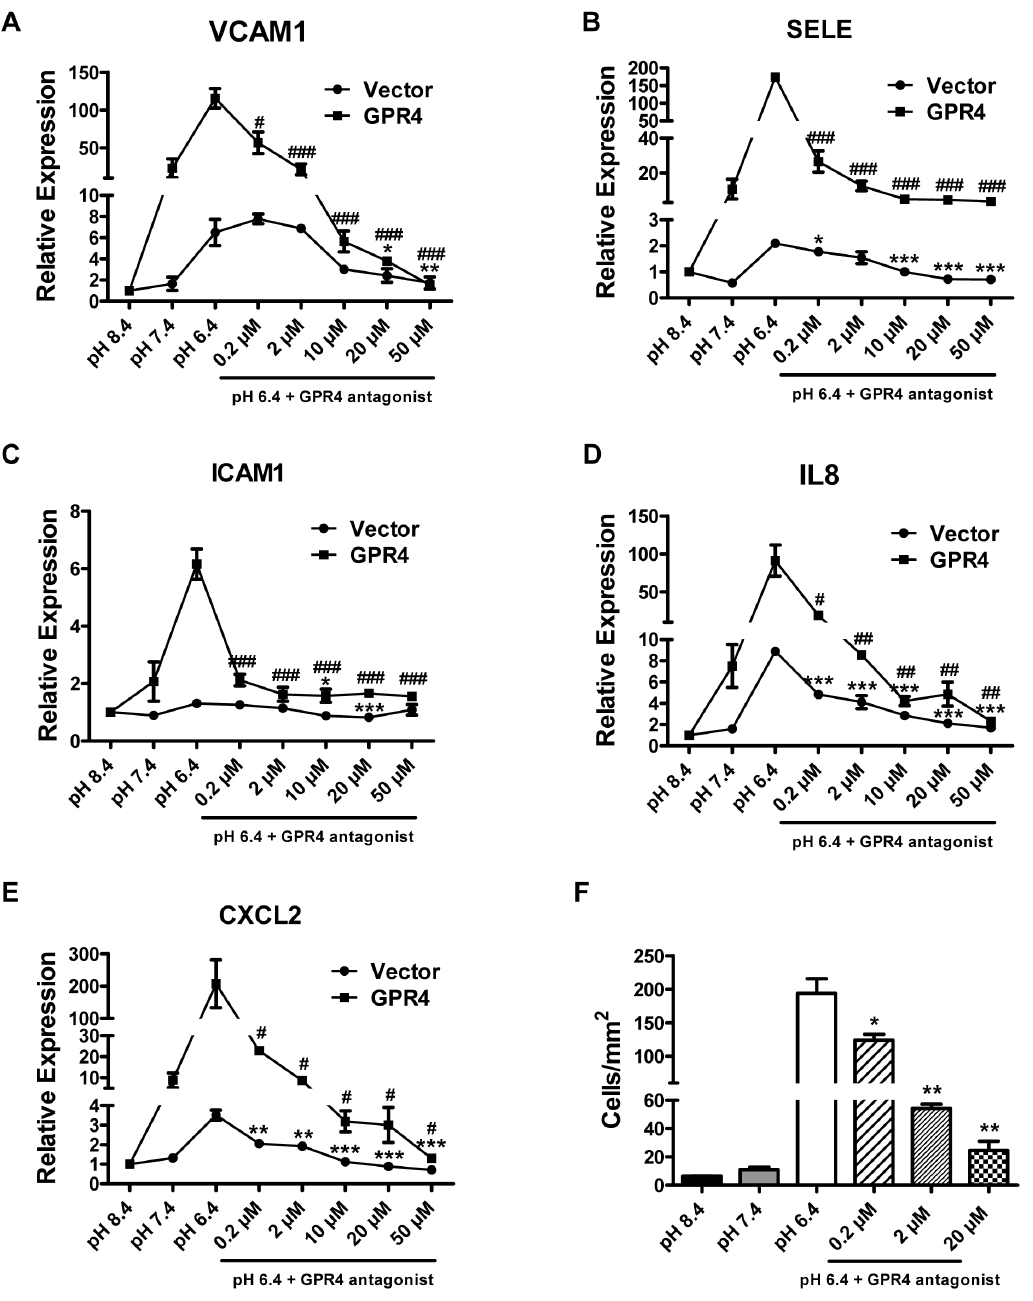
Figure 9. Inhibition of GPR4 activation by its antagonist attenuates the expression of inflammatory genes. (A–E) HUVEC/Vector or HUVEC/GPR4 cells were treated for 5 h with EGM-2/HEM pH 8.4, 7.4 or 6.4 media, or with pH 6.4 media containing indicated concentrations of GPR4 antagonist. Total RNA was isolated and cDNA was synthesized. Real-time RT-PCR quantification of gene expression of VCAM1 (A), SELE (B), ICAM1 (C), IL8 (D) and CXCL2 (E) was performed. The expression level of the target gene in HUVECs at pH 8.4 was set as 1. Error bars indicate the mean 6 SEM. *, P , 0.05; **, P , 0.01; ***, P , 0.001; compared with the pH 6.4 vehicle control in HUVEC/Vector cells. # , P , 0.05; ## , P , 0.01; ### , P , 0.001; compared with the pH 6.4 vehicle control in HUVEC/GPR4 cells. The results shown are the average of at least two biological repeats. (F) HUVECs stably overexpressing GPR4 were grown to form a monolayer. Cells were then pretreated with vehicle or GPR4 antagonist (at indicated concentrations) for 1 h, followed by the treatment with indicated pH media or pH 6.4 medium containing indicated concentrations of GPR4 antagonist for 5 h. The static cell adhesion assay was then performed using U937 monocyte binding as a functional readout as previously described [13]. Error bars indicate the mean 6 SEM. *, P , 0.05; **, P , 0.01; compared with the pH 6.4 vehicle group. The results represent the average of cell counts from 3 fields under an inverted microscope (total 100 6 magnification).